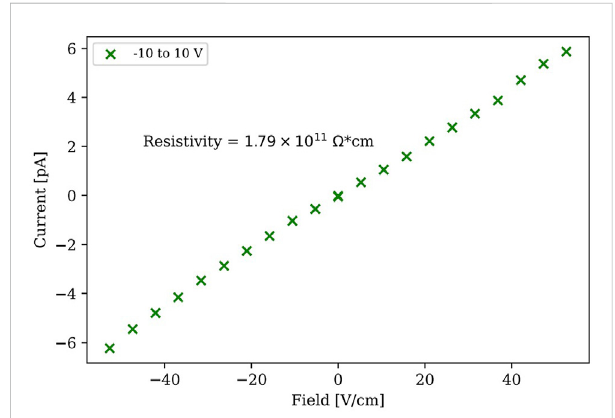
FIGURE 9 Appliedload for20s,heldfor10sat5,000 μ N,andunloadfor20s on a Cs 3 Bi 2 Br 9 single